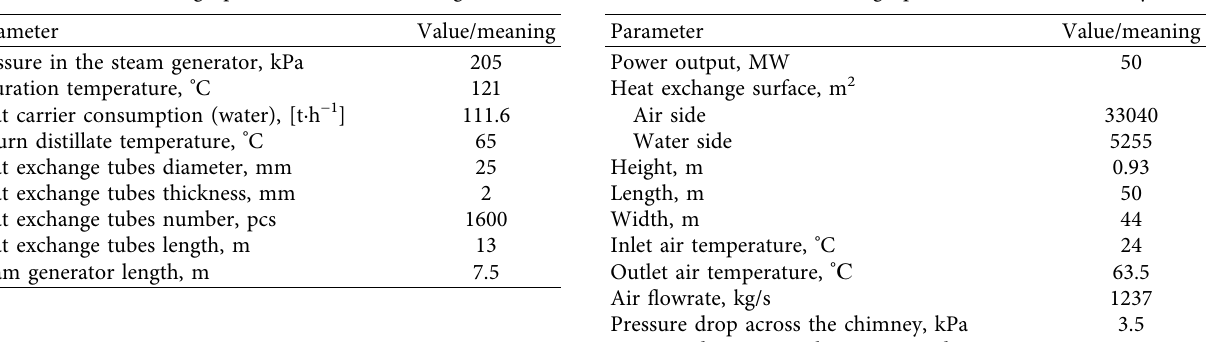
Table 5: The main design parameters of the